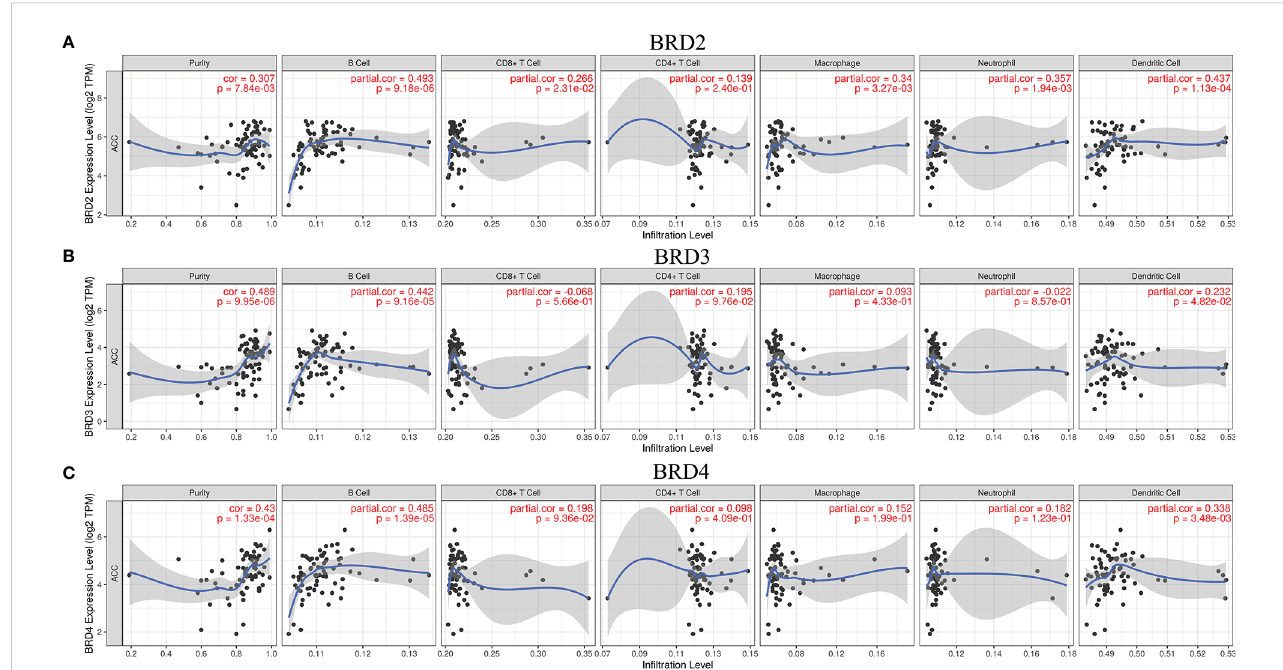
FIGURE 5 The correlation between BET family expression and immune cell in fi ltration levels in ACC (TIMER). (A) BRD2 ; (B) BRD3 ; (C) BRD4